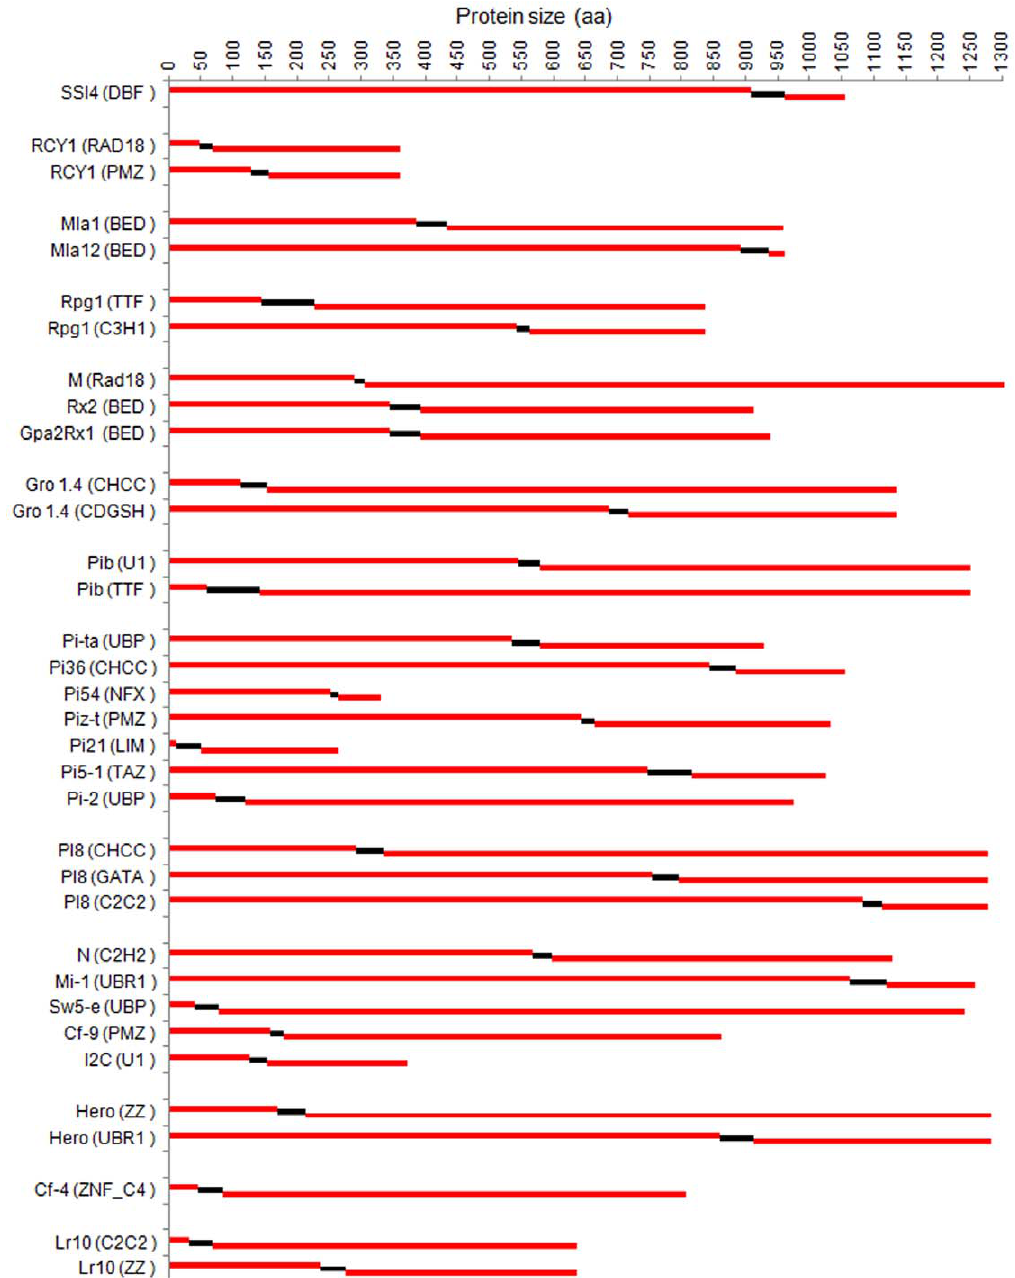
Figure 3. The architecture of zinc finger domains containing R proteins. The scale (0–1300) represents the size of proteins and their domains. The position and number of zinc finger domains in each R genes are also represented in the scale. The black broken lines indicate the zinc finger domains in individual R-proteins.